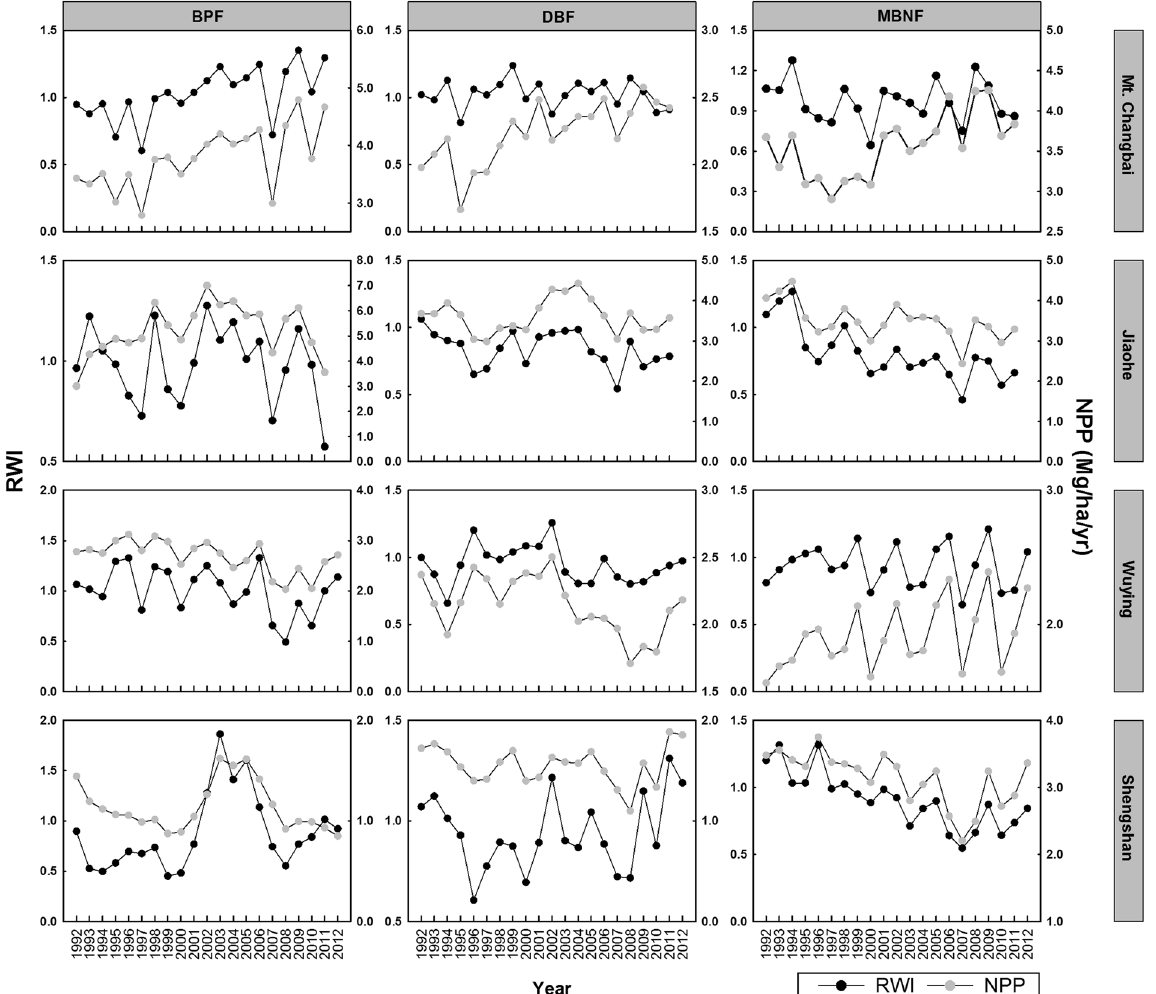
Figure 1. Comparison of temprefd between stand NPP (gray dots, Mg/ha/yr) and standard chronology (RWI, black dots) for each forest type by each site. Abbreviation: BPF, Betula & Populus forest; DBF, deciduous broad- leaved forest; MBNF: mixed broad- & needle-leaved